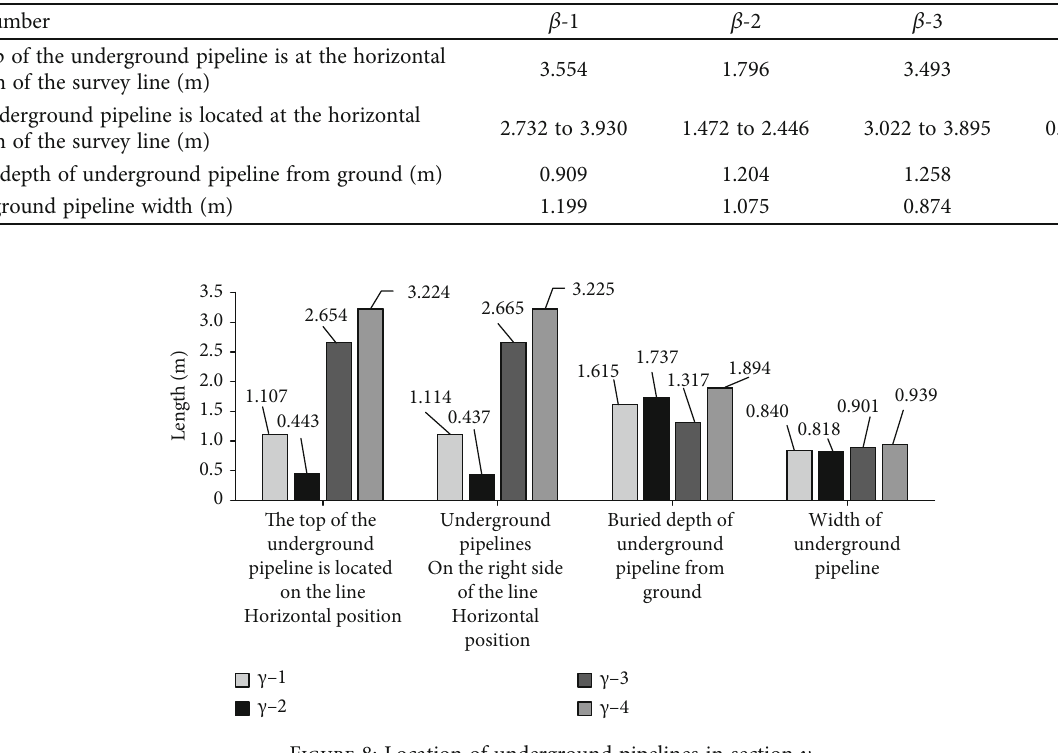
Table 2: Location of underground pipelines in section β .